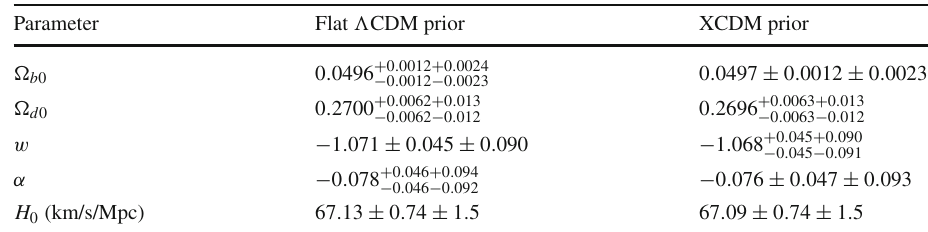
Table 3 Combined constraints on the free parameters of DM-DE interacting model from Pantheon+ H ( z ) +Planck18+BAO